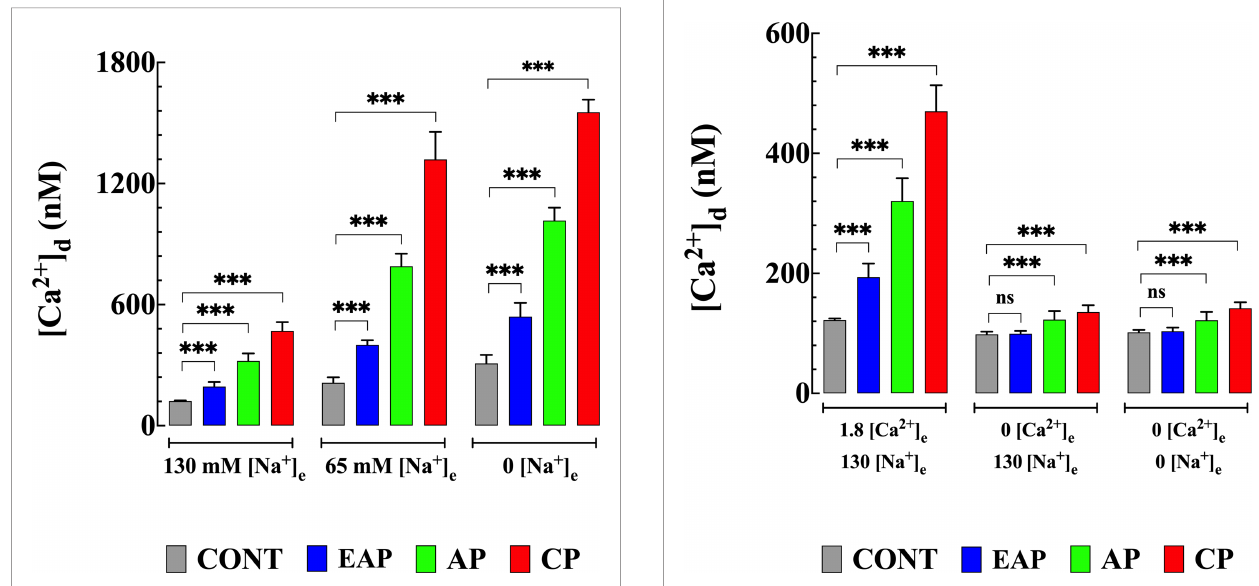
FIGURE 3 | Effects of reduction in [Na + ] e on [Ca 2+ ] d in cardiomyocytes from control and Chagas infected mice. [Ca 2+ ] d was measured before and after cardiomyocyte treatments with solutions in which [Na + ] e was partially or completely replaced with NMG. [Ca 2+ ] d was determined in quiescent cardiomyocytes from CONT mice ( n cells =13-24 and n mice =4), EAP-infected mice ( n cells =12-19 and n mice =5), AP-infected mice ( n cells =12-21 and n mice =5) and CP-infected mice ( n cells =6-18 and n mice =9). Data are expressed as means ± S.D. Statistical analysis was performed as described above, *** p < 0.001. CONT, control mice; EAP, early acute phase of infected mice; AP, acute phase of infected mice; and CP, chronic phase of infected mice.